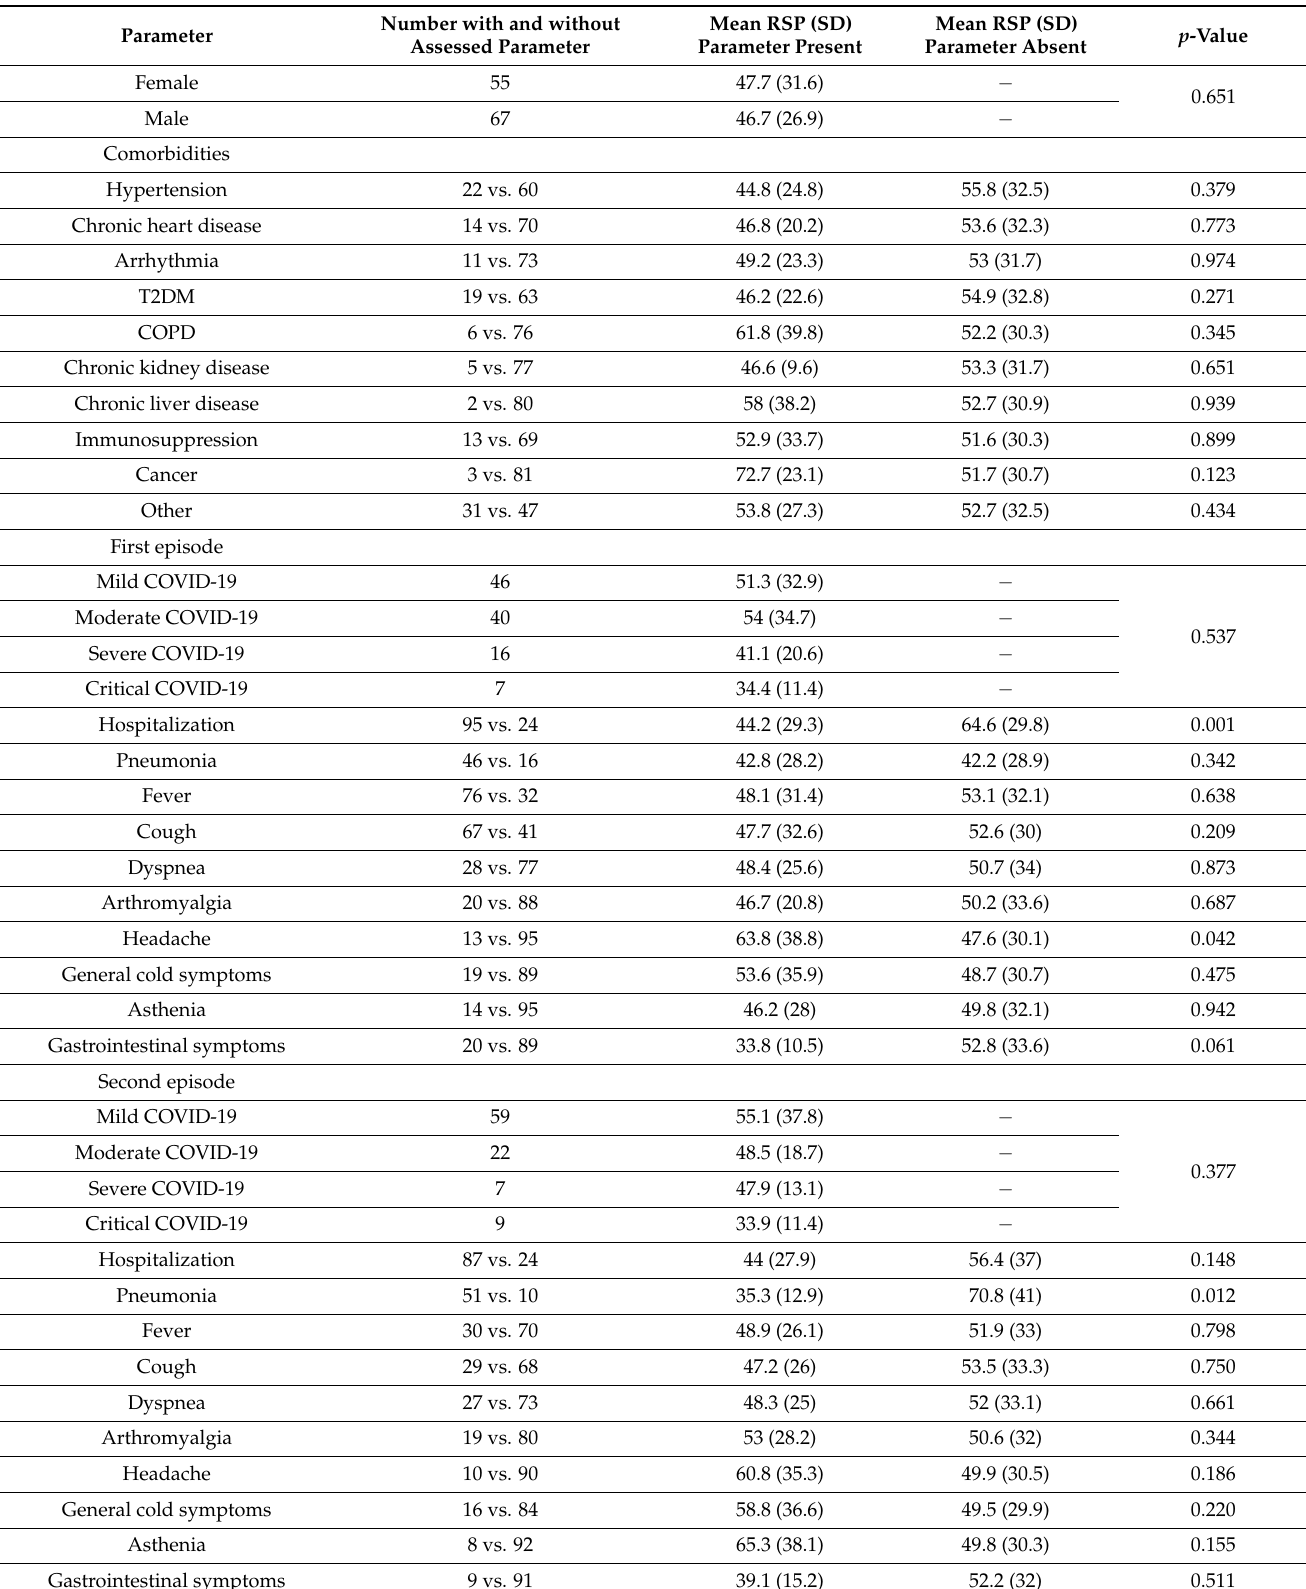
Table 2. Mean repeated positivity length based on the listed